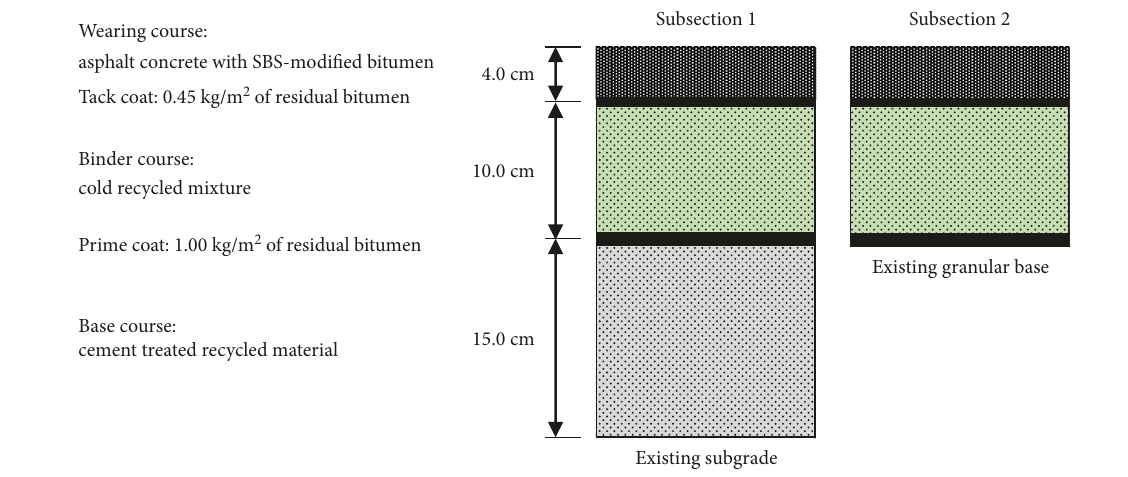
Figure 2: Structural design for subsections 1 and 2. Table 1: Main properties of used aggregate and